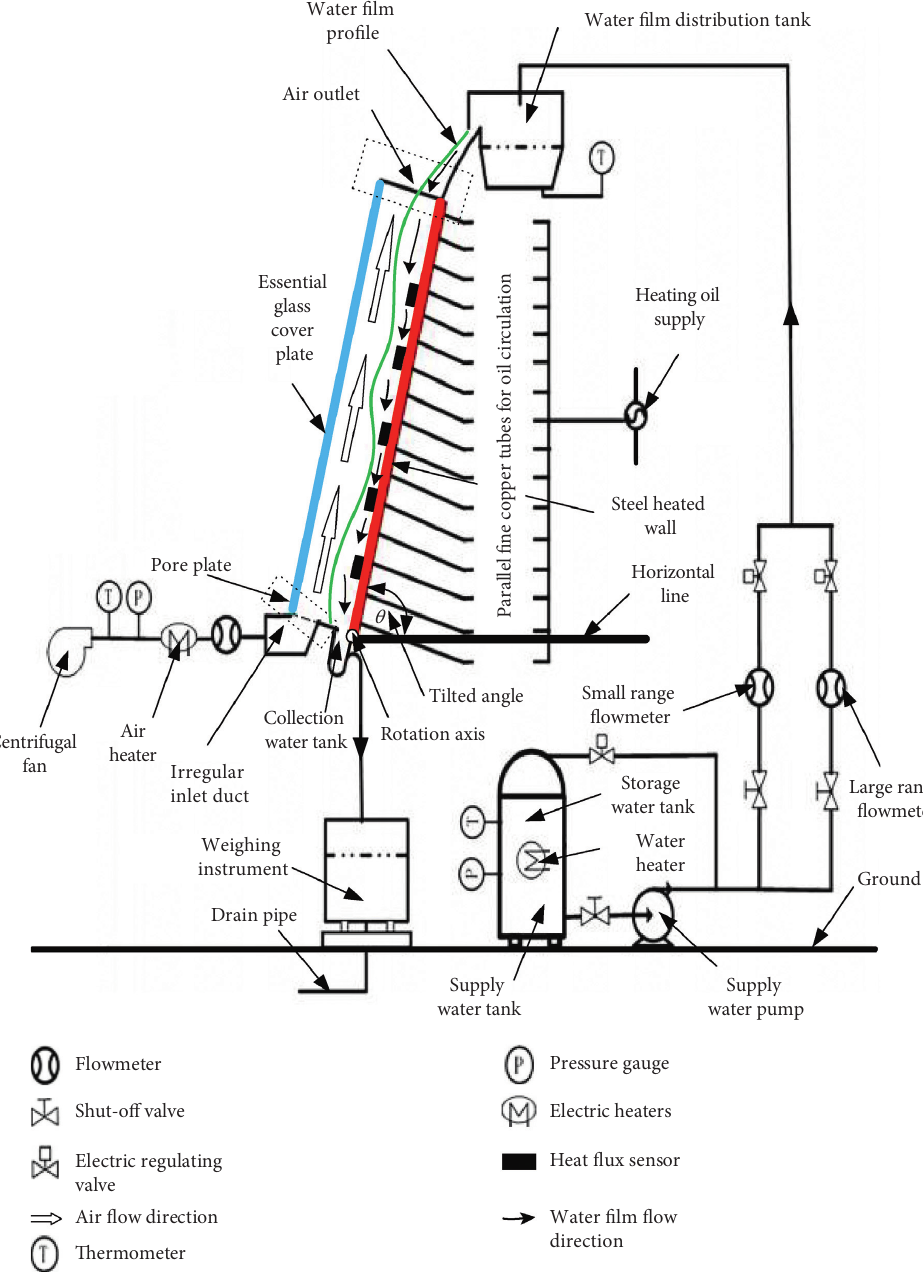
Figure 4: Schematic of the experimental facility.